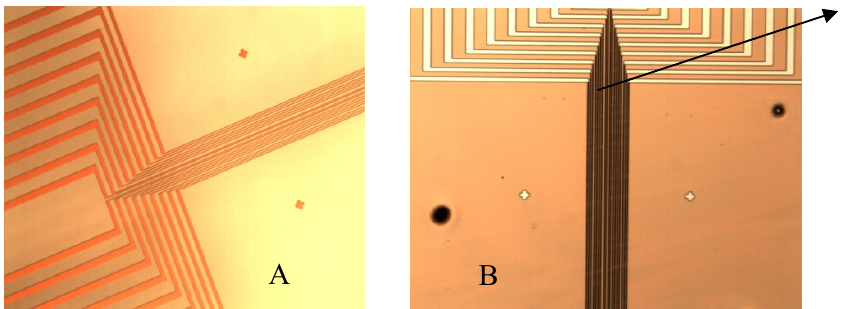
Figure 4. Fabricated microprobe